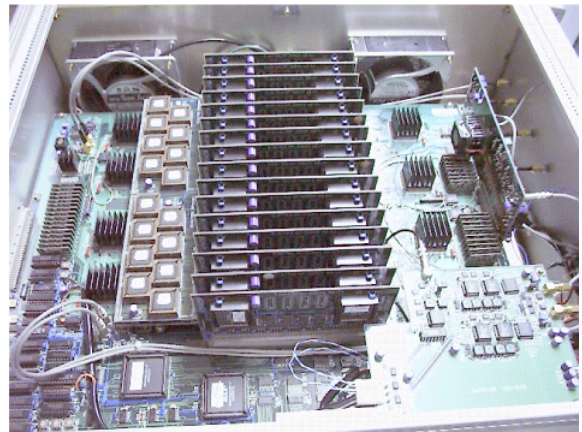
FIG. 6. (Color) Photograph of the filter